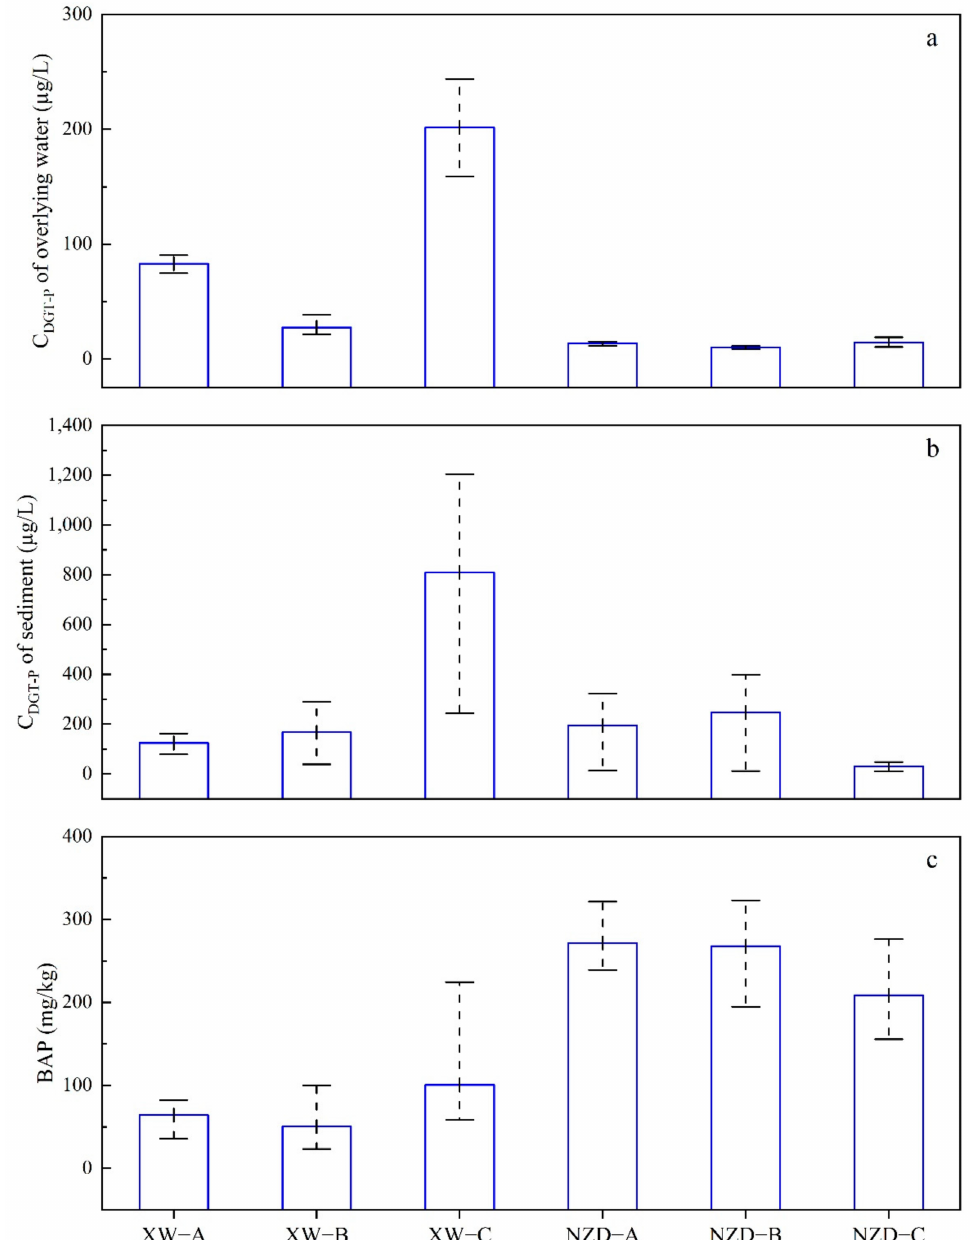
Figure 4. Spatial distribution of ( a ) the C DGT-P in overlying water, ( b ) the C DGT-P in sediment cores, and ( c ) solid bioavailable phosphorus (BAP) in sediment